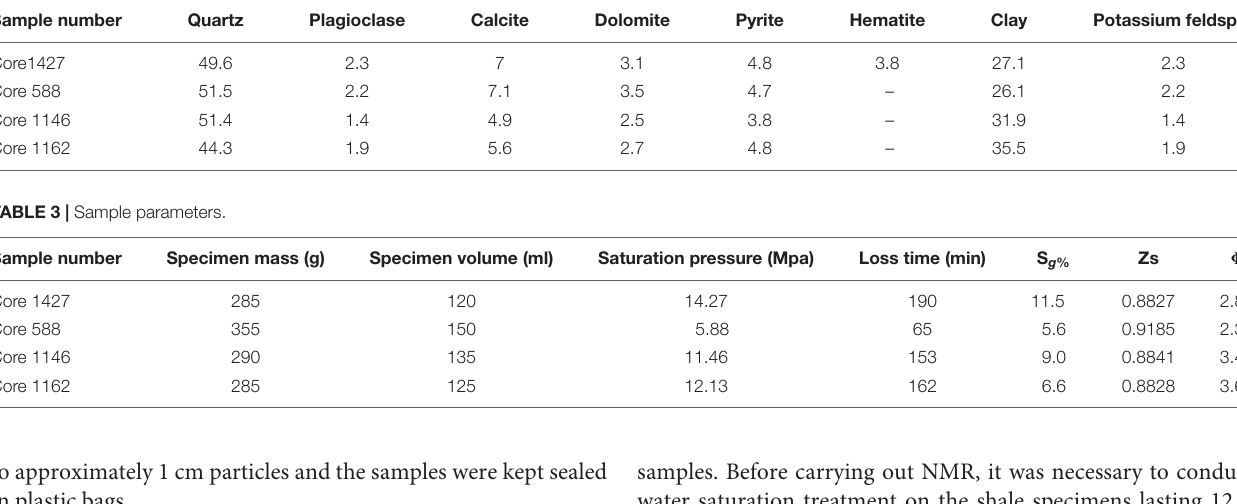
TABLE 2 | Mineralogical composition (%) of shale samples.